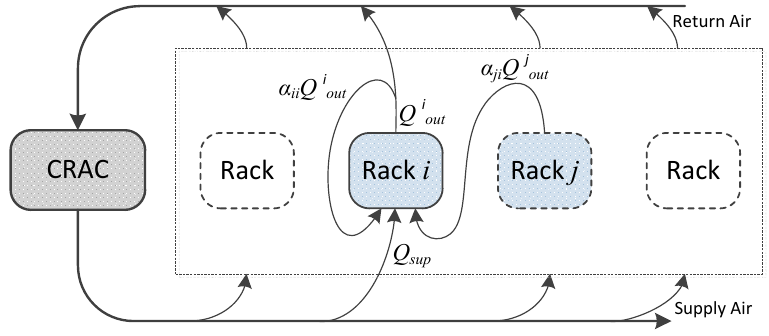
Figure 2. Schematic of typical thermal cross-interference among